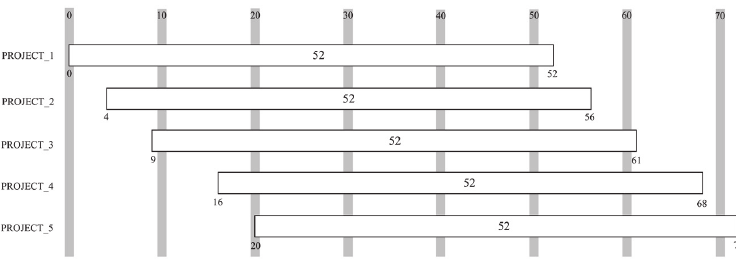
Fig. 4. Critical-path duration (CPD) of the five projects that comprise the portfolio